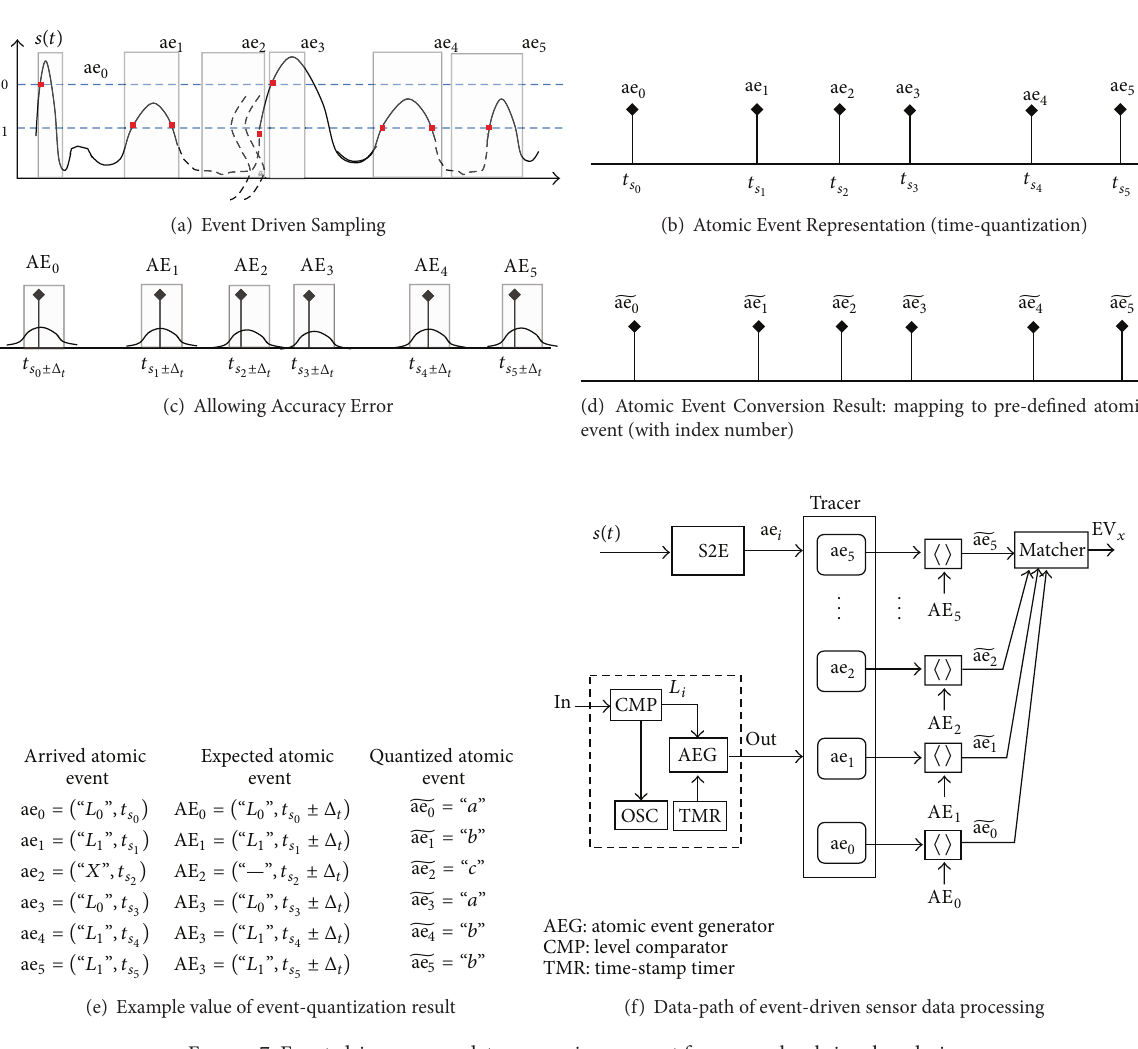
Figure 7: Event-driven sensor data processing concept for macro-level signal